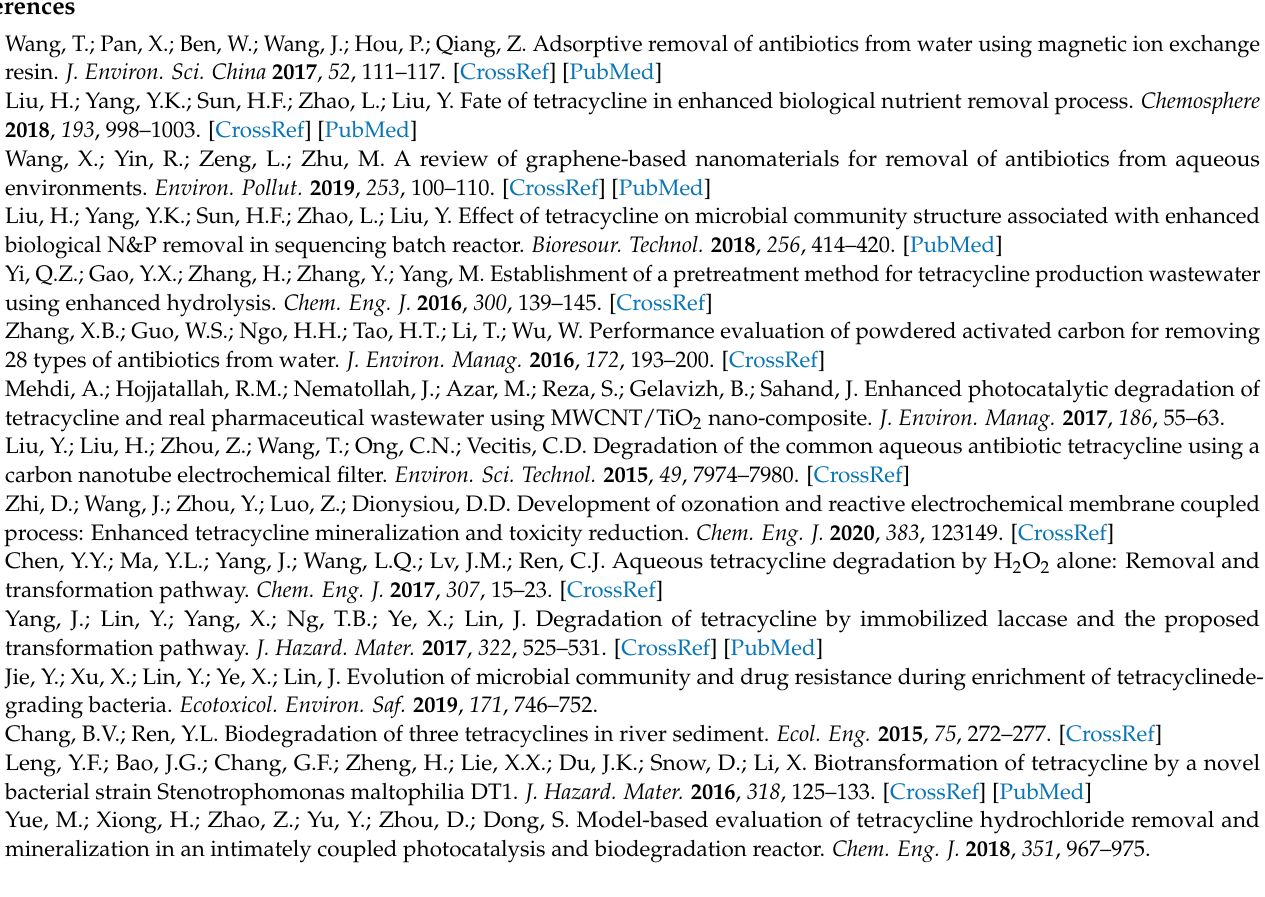
Figure S2. The morphology and EDS-maping of the pure sheet MXene (Ti 3 C 2 ); Figure S3. SEM images of 1-TC/CN, 3-TC/CN, 5-TC/CN; Figure S4. The the reusability of 2-TC/CN MXene composite; Figure S5. UV-vis spectra of the pure Mxene (Ti 3 C 2 ); Table S1. Valence band, band gap and conduction band computation procedure of the samples; Table S2. Comparison of the photocatalytic activity of degrading tetracycline of the prepared 2-TC/CN with that of photocatalysts in literature; Table S3. The calculation procedure of the lifetime of photogenerated carriers. References [65–67] are cited in the supplementary